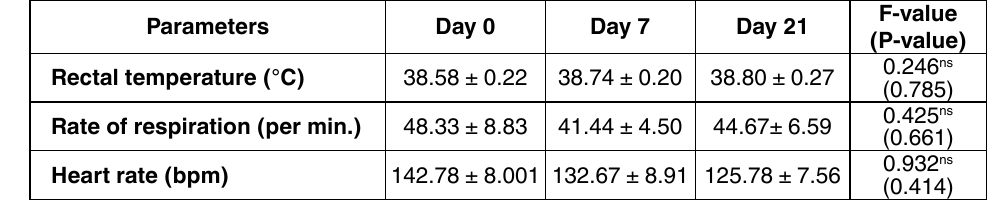
table2. Details of the physiological parameters (Mean ± SE) in tom cats